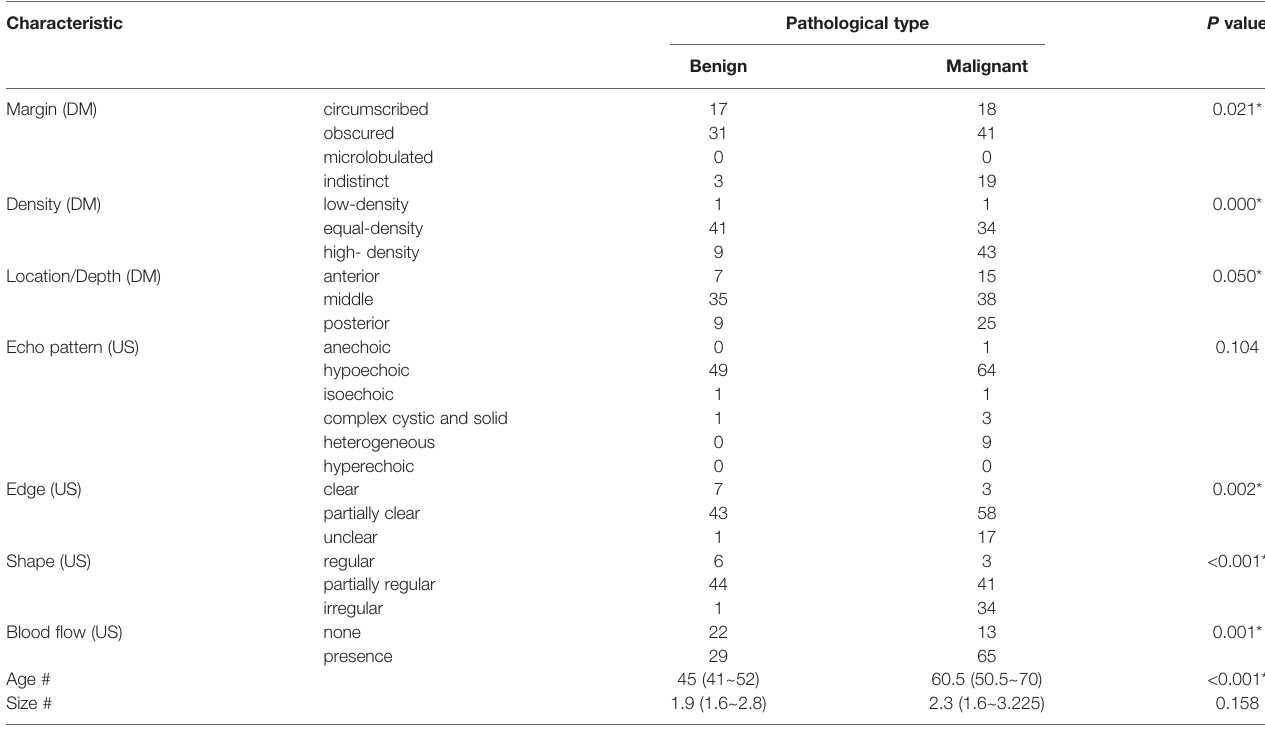
TABLE 2 | Patient and DM/US characteristics. Characteristic